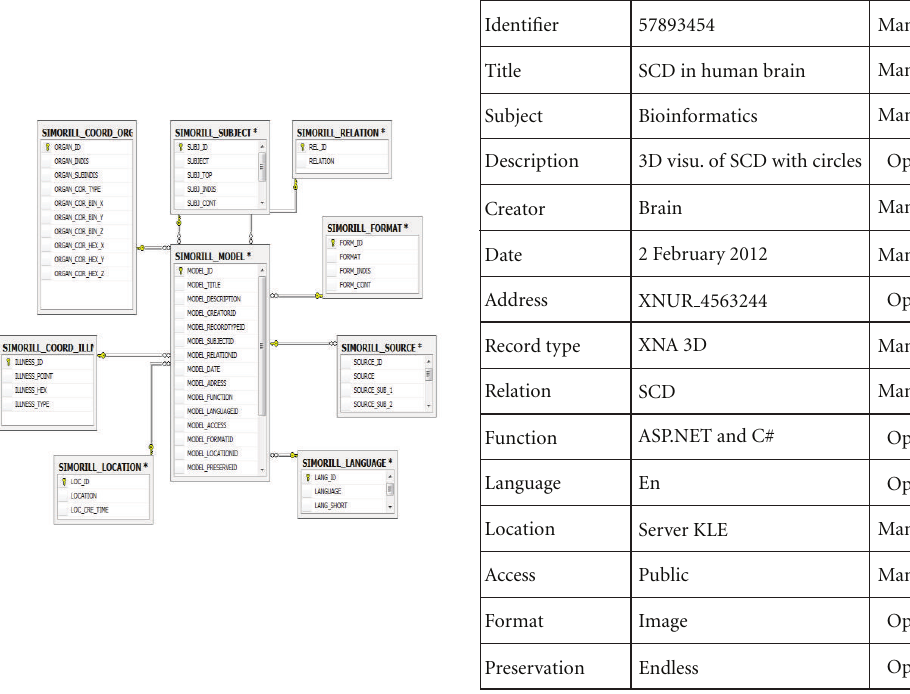
Figure 1: SIMORILL DAT database table elements and a model SIMORILL METDAT metadata.